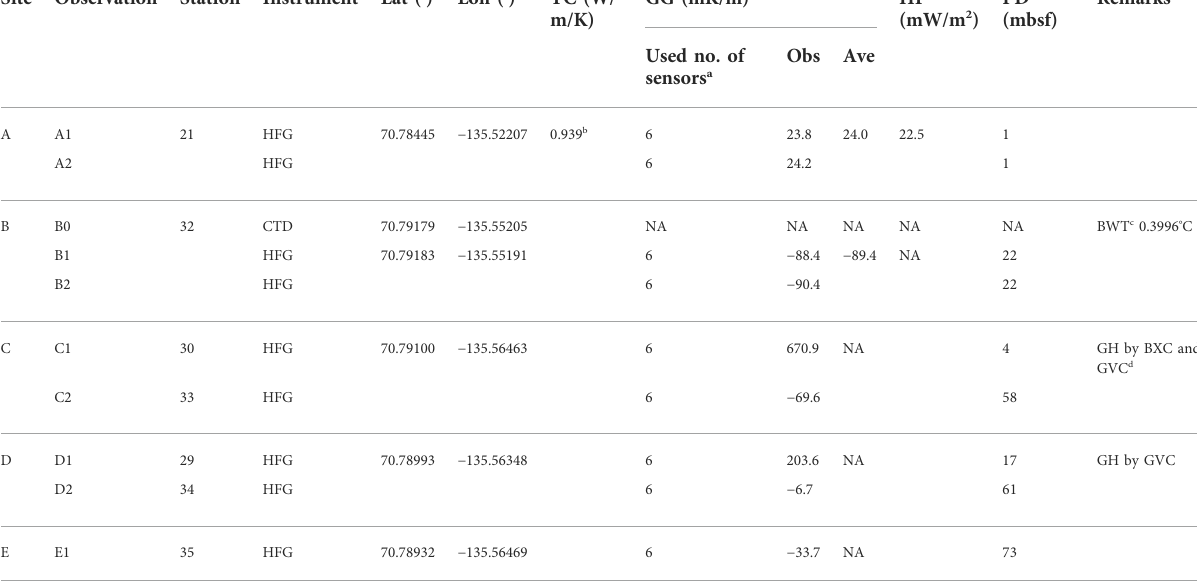
TABLE 1 Summary of site locations and results. TC, thermal conductivity; GG, geothermal gradient; HF, heat fl ow; PD, penetrating depth; HFG, heat fl ow probe for geothermal gradient; CTD, conductivity-temperature-depth. Site Observation Station Instrument Lat ( ° ) Lon ( °